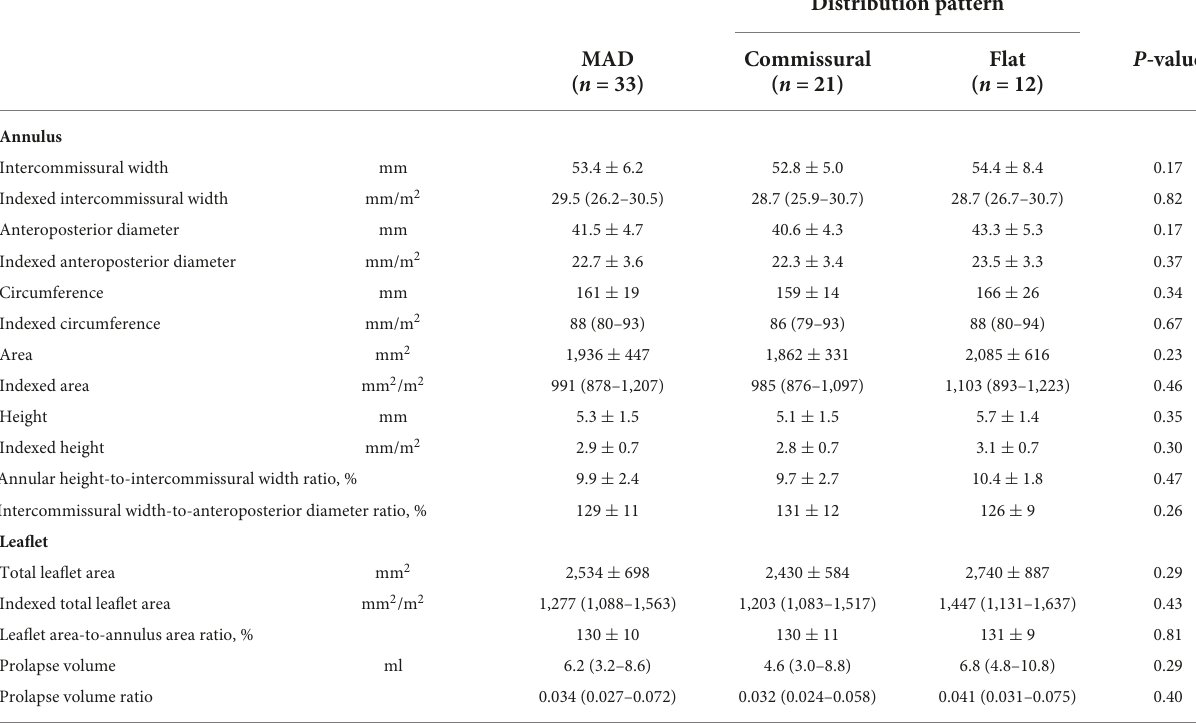
Table 3 . The patients with a flat phenotype of